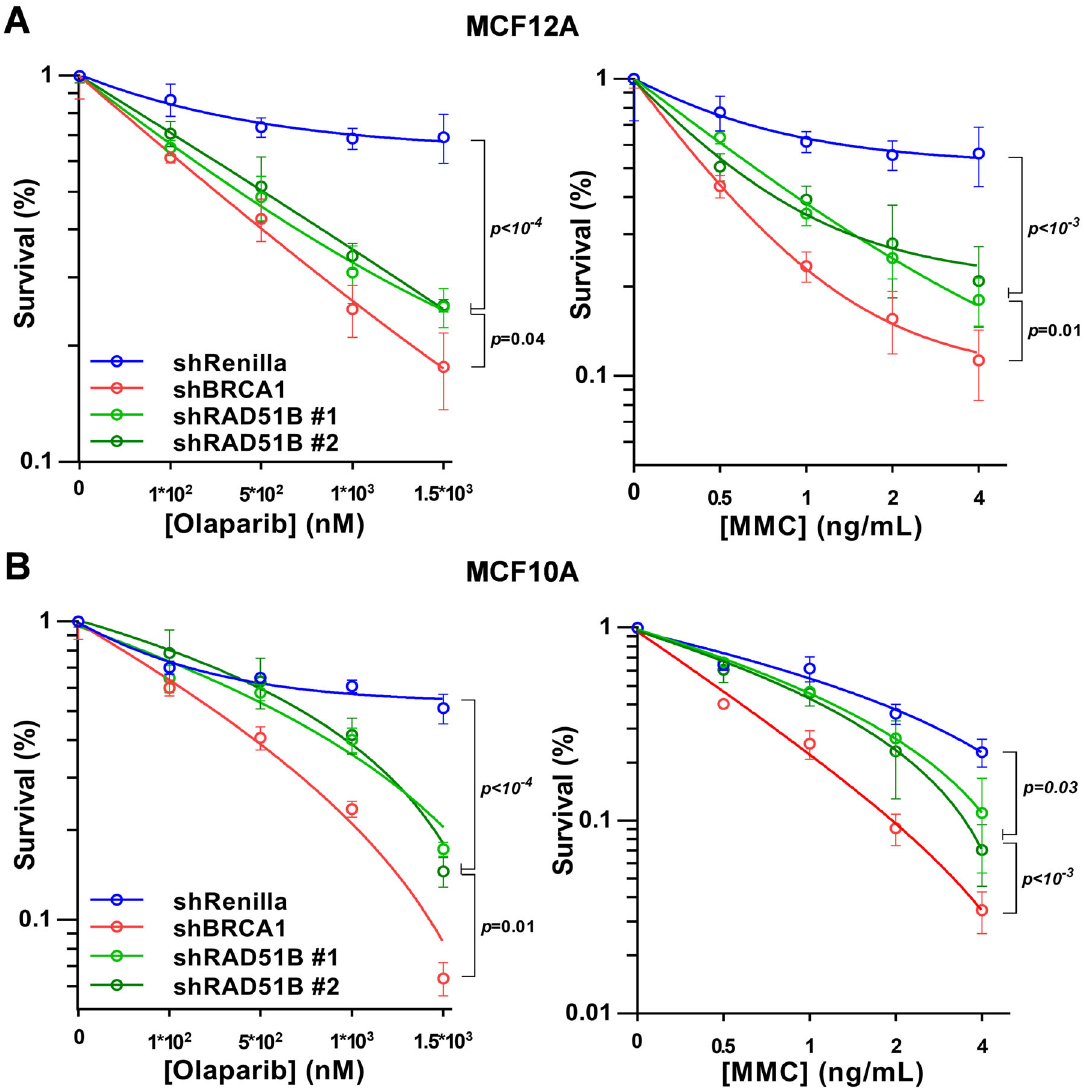
Fig. 4 RAD51B-de fi ciency and sensitivity to MMC and PARPi. A , B Clonogenic survival assays of the indicated cell lines in response to olaparib or mitomycin C. Cells were expressing one of two independent RAD51B shRNAs, Renilla shRNA (nontarget control), or BRCA1 shRNA (positive control). Error bars represent